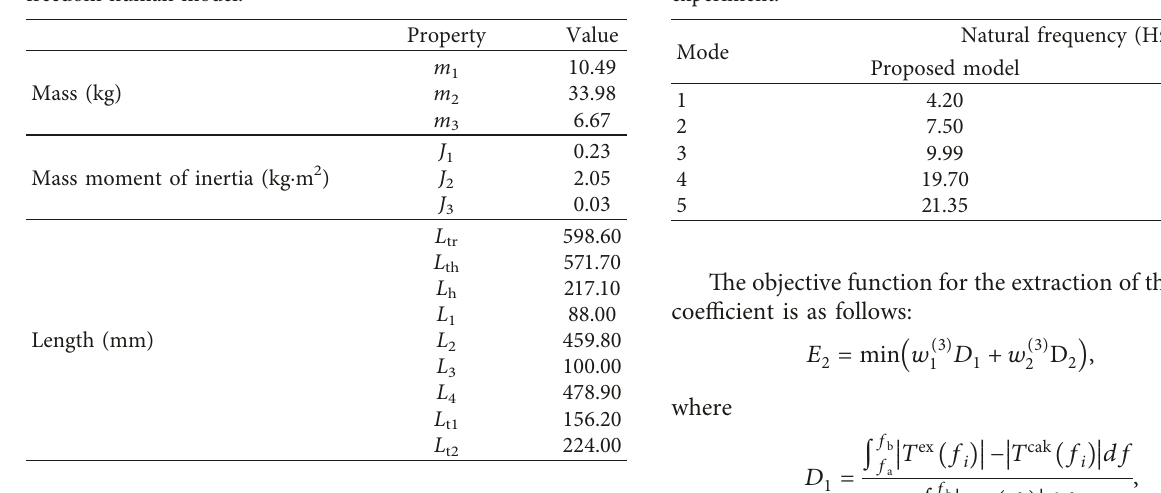
Table 1: Inertial properties and length data of the five-degree-of- freedom human model.